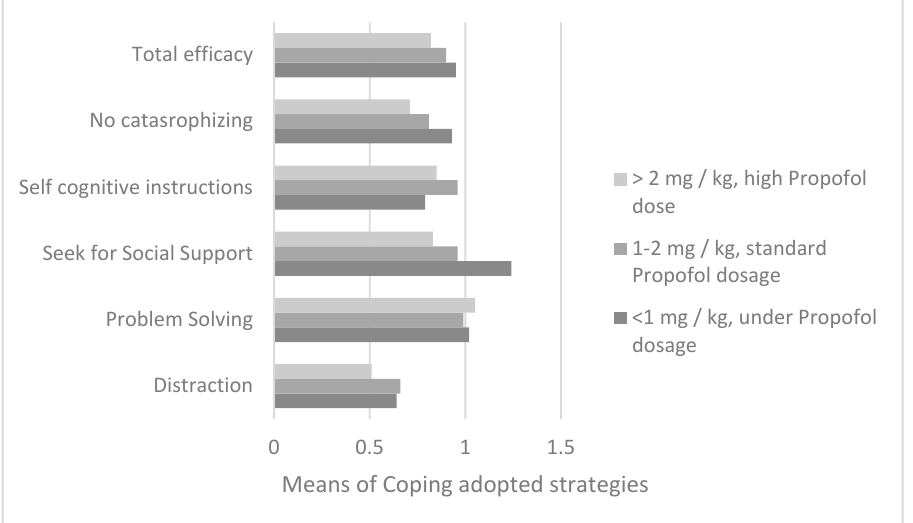
Figure 3. Comparison between the averages of the 5 coping strategies adopted along the average dosage of propofol taken in the sedation induction phase for the diagnostic bone marrow aspirate. Regarding the bone marrow aspirate on day +15 (n = 100), a different dose of the anesthetic drug was found if the child used the social support strategy (F = 9.7; df = 2; p = 0.0001) and non-catastrophizing (F = 13.33; df = 2; p = 0.0001). With the Bonferroni post-hoc test a significant prevalence of the social support strategy was evidenced comparing ranges 2 and 3 of propofol dosages (M range1 = 1.22; DS range1 = 0.34; I-J 2 = 0.27; p 2 = 0.001; M range2 = 0.95; D range2 = 0.35 and I-J 3 = 0.46; p 3 = 0.008; M range3 = 0.76; DS range3 = 0.35), and also non-catastrophizing (M range1 = 1.03; DS range1 = 0.32; I-J 2 = 0.32; p 2 = 0.00001; M range2 = 0.71; DS range2 = 0.34 and I-J 3 = 0.49; p 3 = 0.003; M range3 = 0.54; DS range3 = 0.46) (Figure 4).